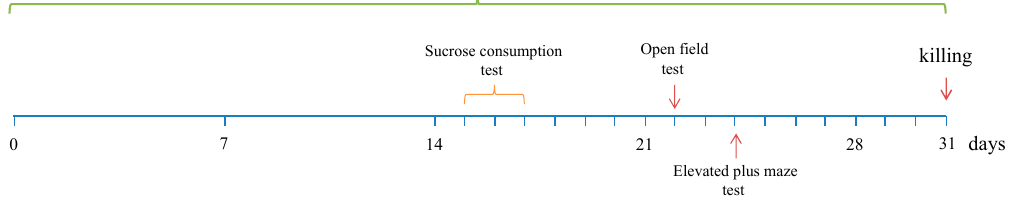
Figure 1. Experimental paradigm. The sucrose consumption test was performed at day 15 to 17, the open field test were conducted at day 22 and the elevated plus maze test at day 25 after the start of the EE. At day 31, animals were killed for the molecular analyses.